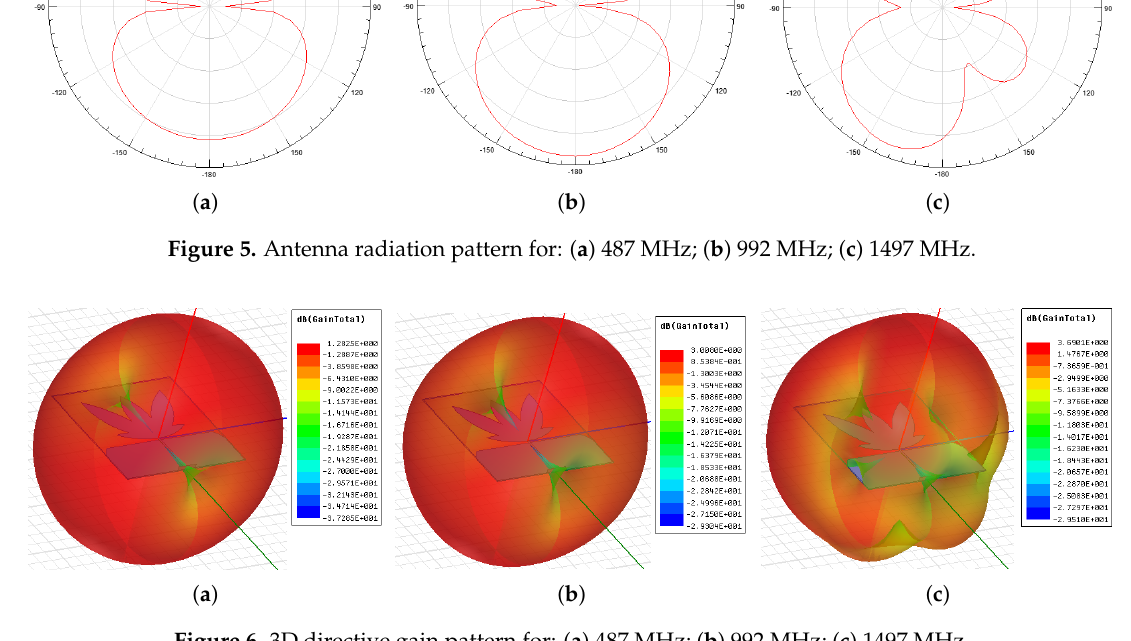
Figure 6. 3D directive gain pattern for: ( a ) 487 MHz; ( b ) 992 MHz; ( c ) 1497